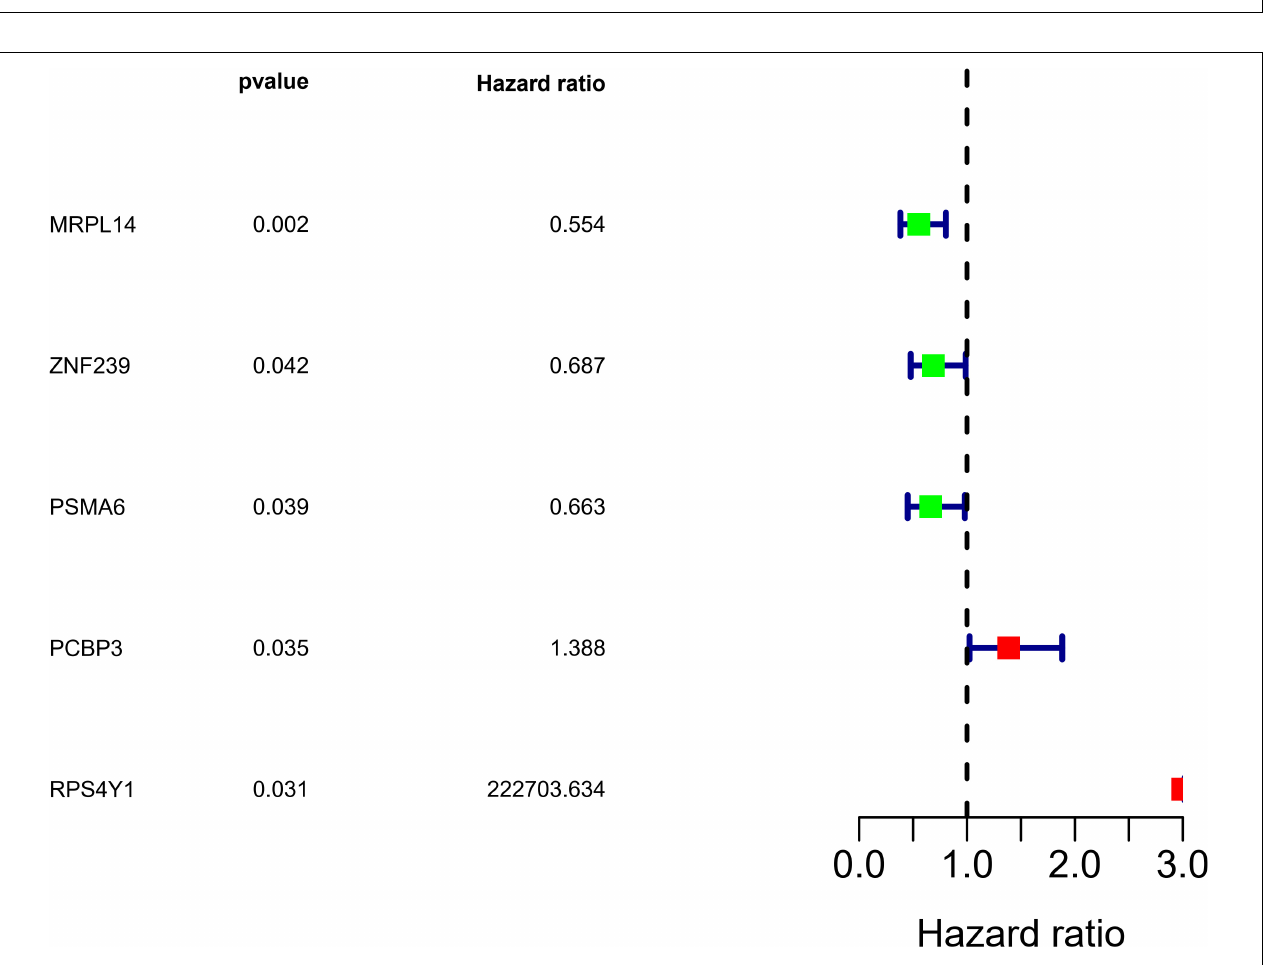
FIGURE 4 | Protein-protein interaction network and modules analysis. (A) Protein–protein interaction network of differentially expressed RBPs. (B) Three critical modules from PPI network. Green circles: downregulation with a fold change of more than 2. Red circles: upregulation with fold change of more than 2.